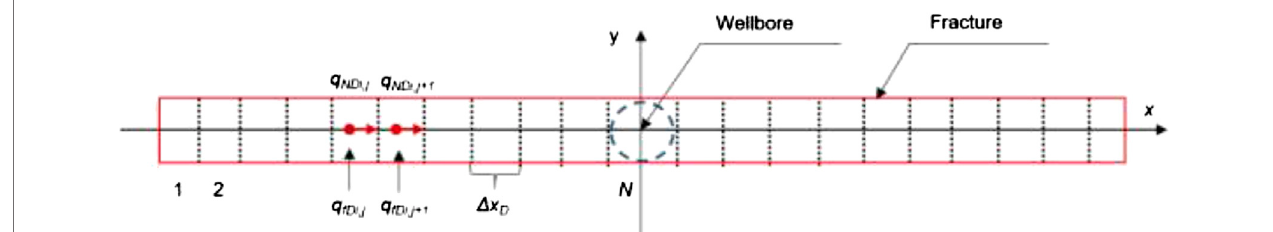
FIGURE 2 | Schematic diagram for the discretized fracture model in a multi-well pad scheme.